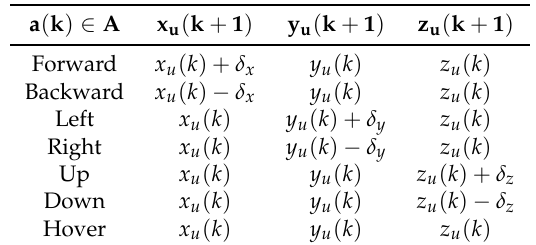
Table 1. Set of chosen actions for the problem formulation. Each action is a position command where δ is the magnitude of change of position coordinates x u , y u and z u from time step k to time step k + 1. Position values are referenced to the world coordinate